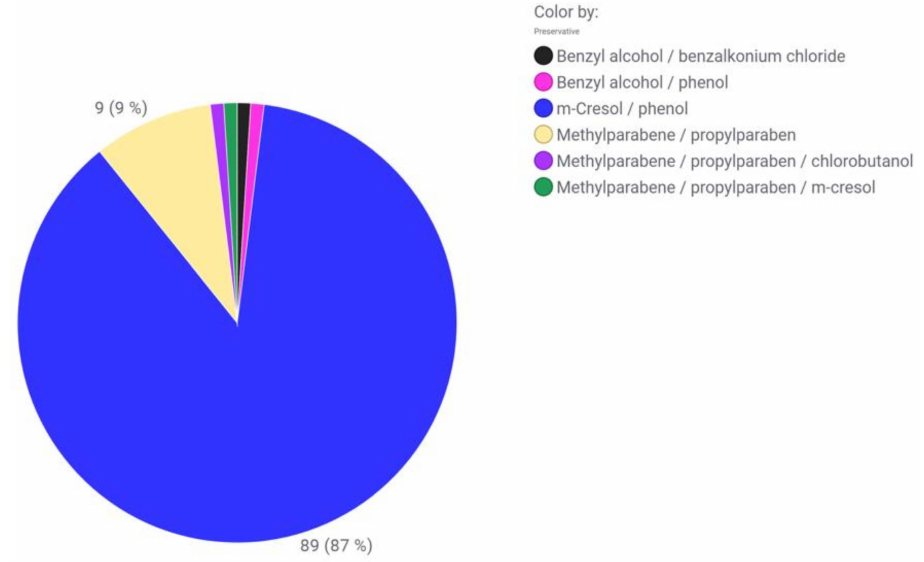
Figure 5. Distribution of preservative combinations containing 2 or 3 preservatives in licensed protein, peptide, or antibody